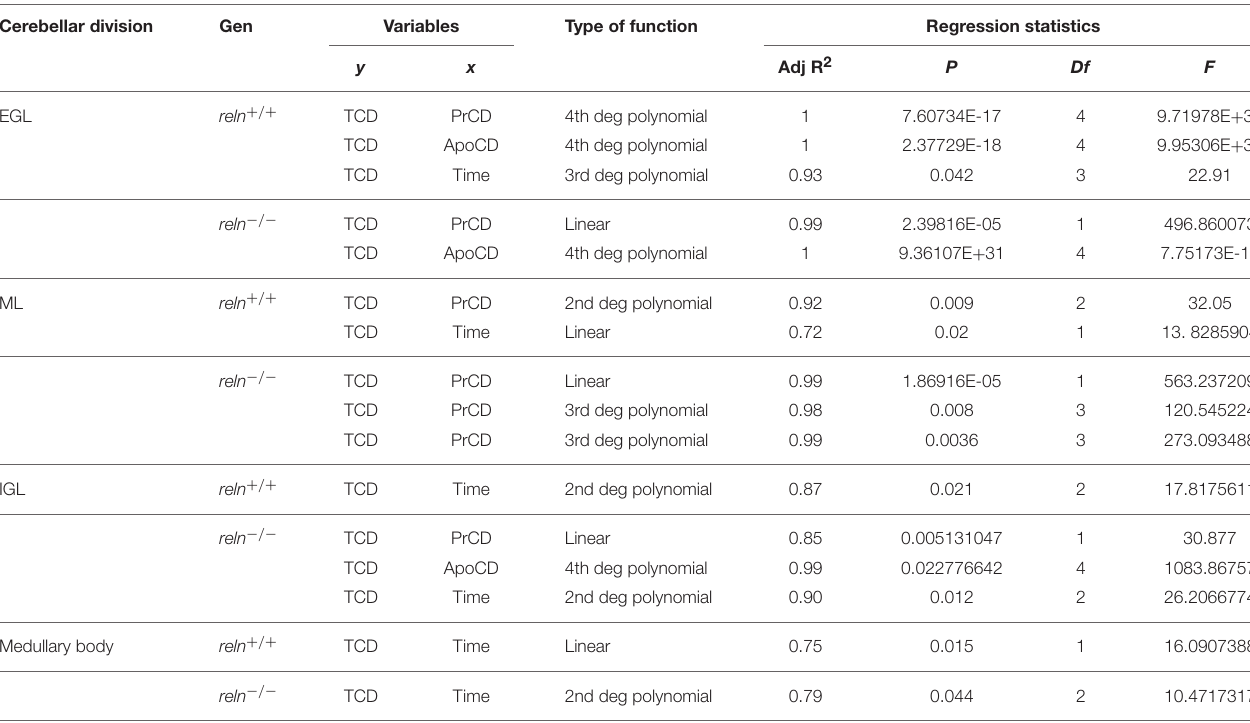
TABLE 3 | Regression analysis of TCD with PrCD, ApoCD or